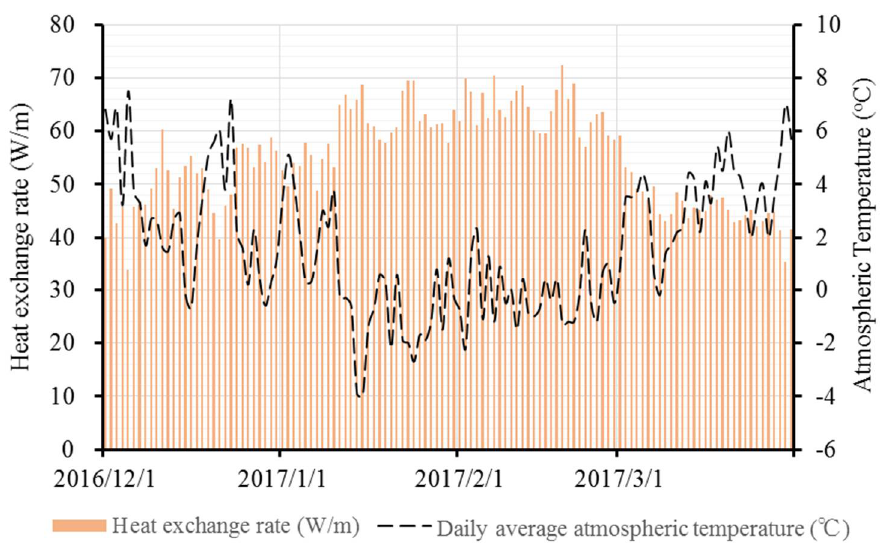
Figure 11. Variation of heat exchange rates of the system using an artesian well for space heating.